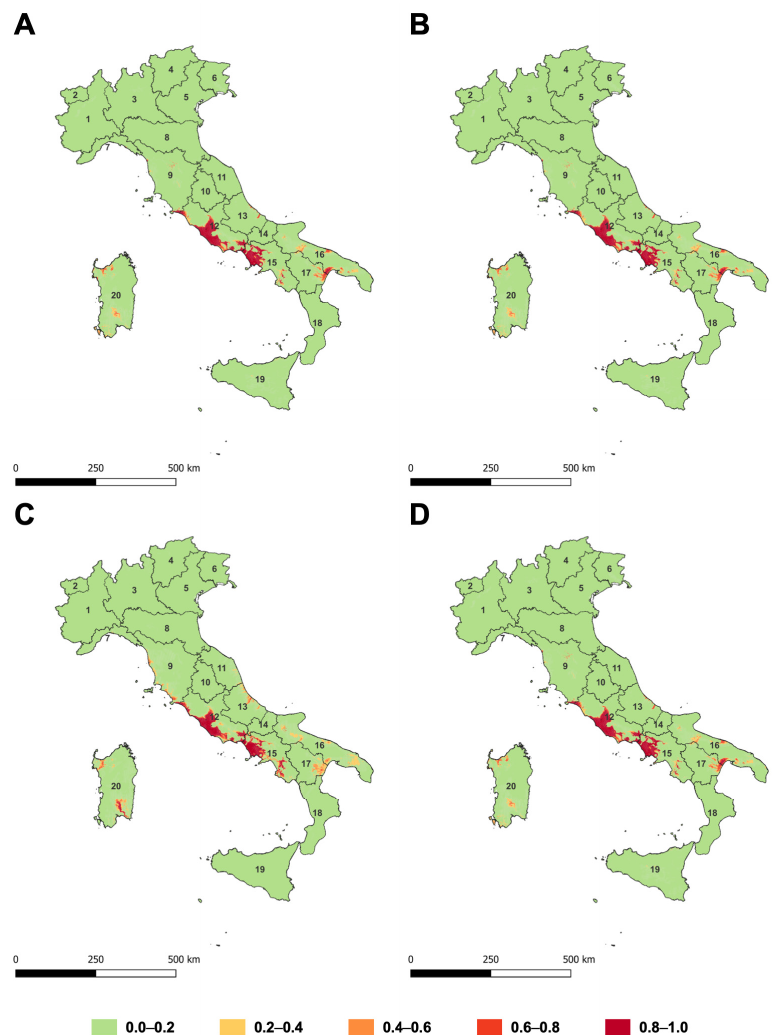
Figure 3. Distribution of suitable areas for Toumeyella parvicornis in Italy based on bioclimatic variables using Generalized Linear Model (GLM) ( A ), Multivariate Adaptive Regression Splines (MARS) model ( B ), MaxEnt model ( C ), and Random Forest (RF) model ( D ). Different colours indicate “classes of suitability” (green = very low; yellow = low; light orange = intermediate; dark orange = high; red = very high). Numbers in maps refer to Italian administrative regions (1 = Piemonte; 2 = Valle d’Aosta; 3 = Lombardia; 4 = Trentino Alto Adige; 5 = Veneto; 6 = Friuli Venezia Giulia; 7 = Liguria; 8 = Emilia Romagna; 9 = Toscana; 10 = Umbria; 11 = Marche; 12 = Lazio; 13 = Abruzzo; 14 = Molise; 15 = Campania; 16 = Puglia; 17 = Basilicata; 18 = Calabria; 19 = Sicilia; 20 =